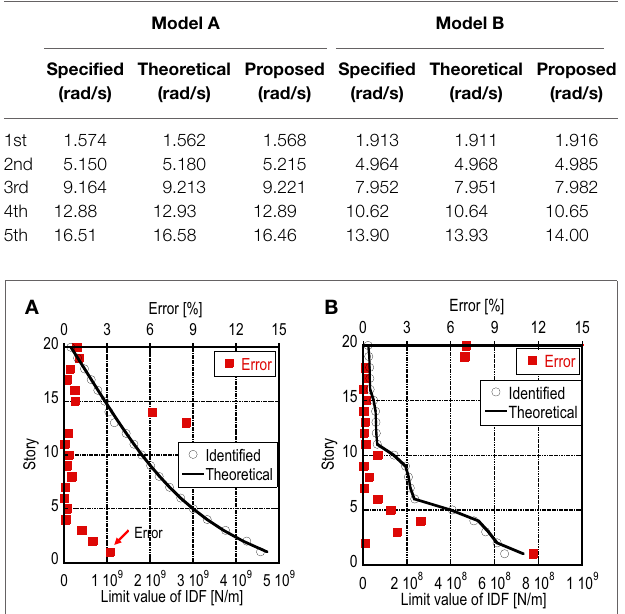
FIGURE 13 | Estimation of limit value of IDF and error: (A) Model A and (B) Model B .